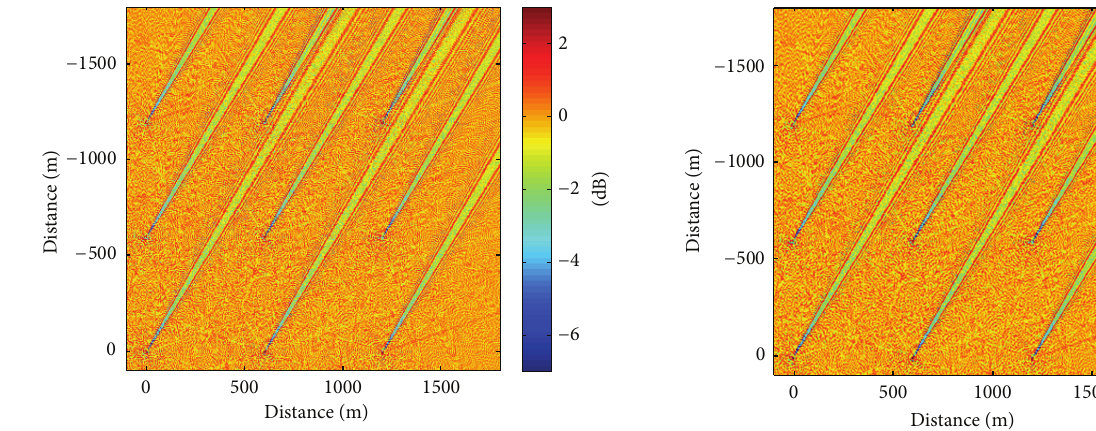
Figure 10: Near-field distribution around a 3 × 3 wind farm at 500